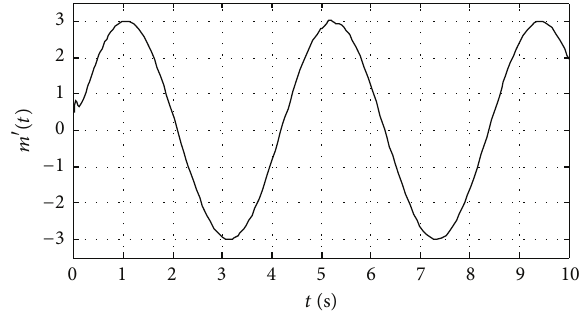
Figure 5: The recovered signal from receiver.